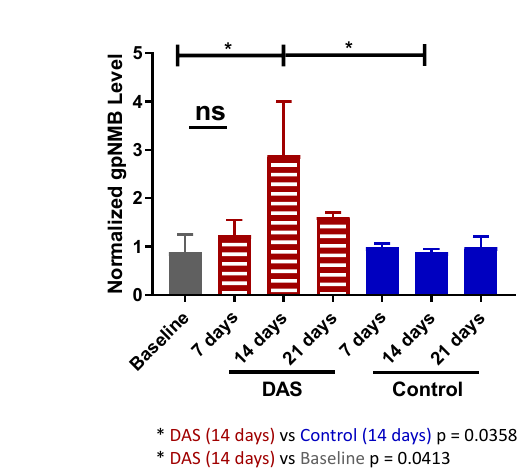
Figure 4. Dasatinib can upregulate the expression of gpNMB in MDA-MB-468-bearing mice. The mice were separated into two groups and were treated with either dasatinib or vehicle control for 21 days. Subgroups of mice (n = 4) were euthanized at different timepoints. Tumors were then